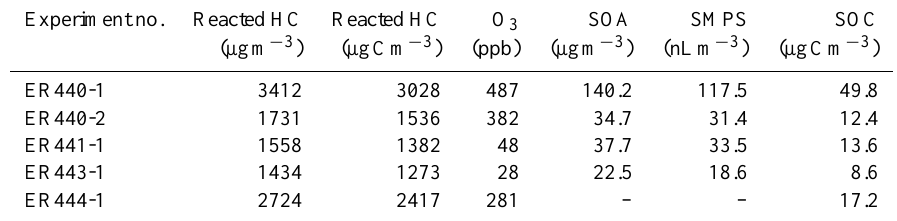
Table 3. Reacted 1,3-butadiene and steady-state parameters determined from SOA produced by 1,3-butadiene oxidation. Experiment no. Reacted HC Reacted HC O 3 SOA SMPS